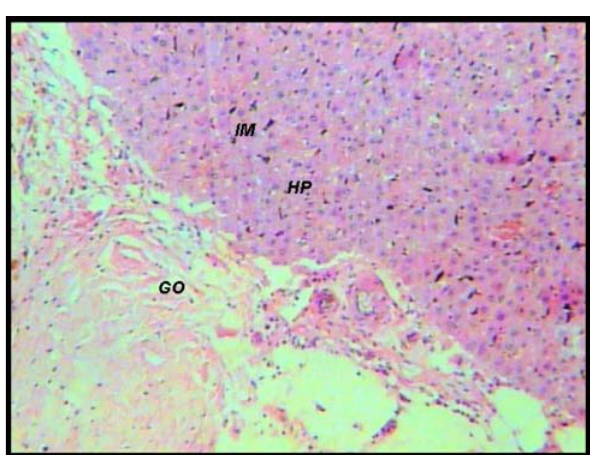
FIGURE 6 - Photomicrography of the omentum-hepatic region showing the points of dark coloration in the hepatic parenchyma ( HP ) and the greater omentum ( GO ), indicating the presence of the ink marker ( IM ). Group with simultaneous HA and PVRB ligation and omental transposition at POD 90, HE,